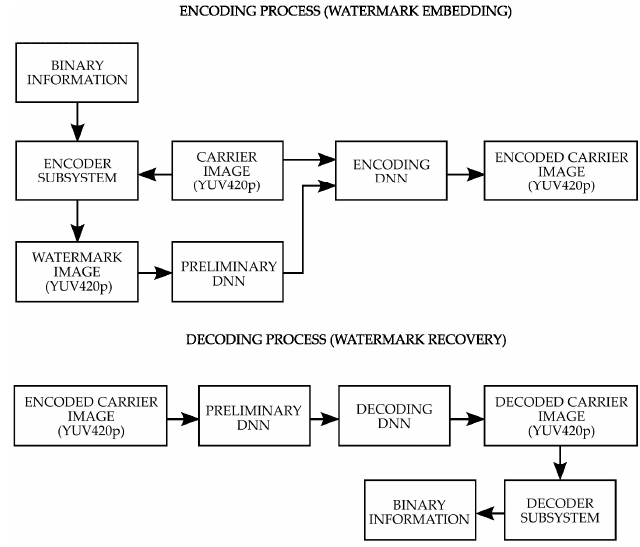
Figure 1. Conceptual diagram of the system.